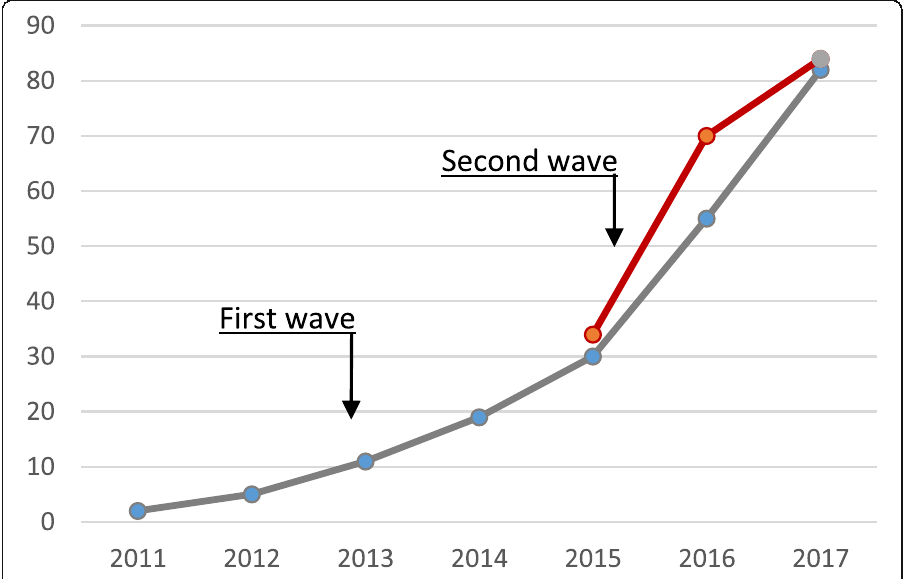
Fig. 2 Time line of co-working spaces ’ development in Cairo, showing the number of co-working spaces rising each year. Elaboration by